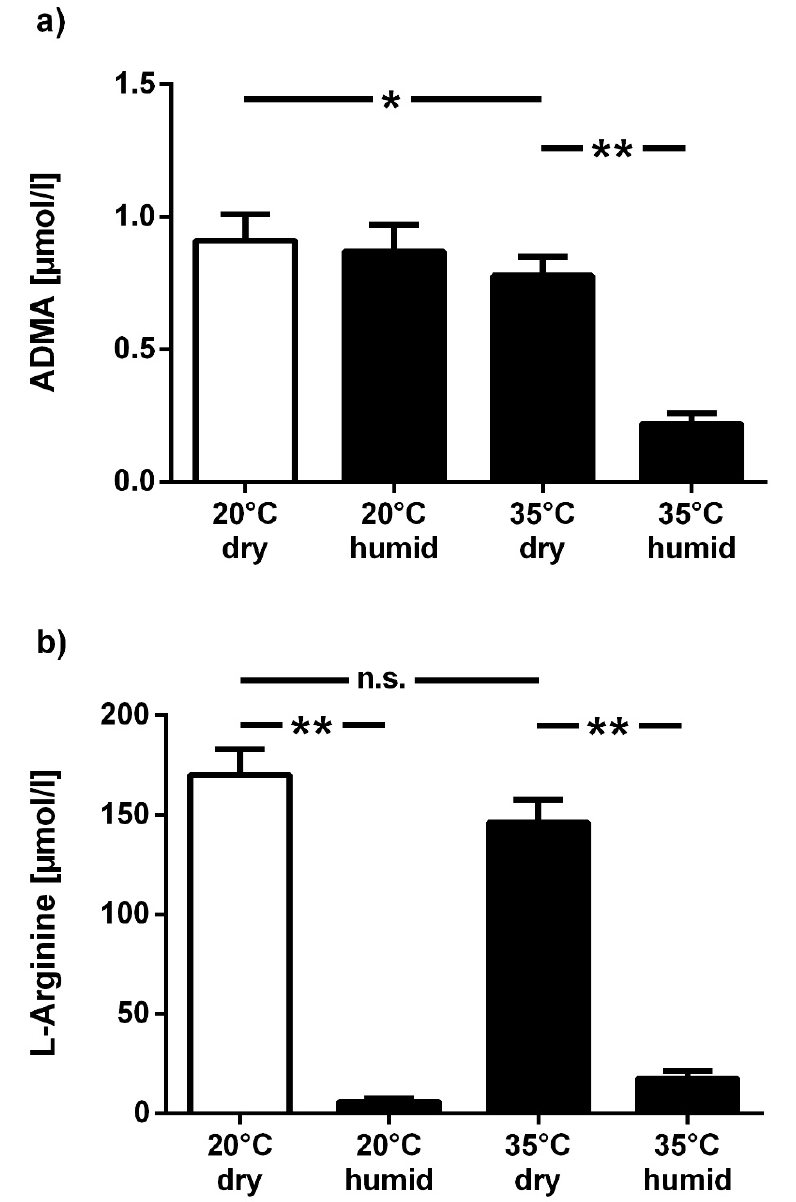
Figure 2. Combined effect of temperature and humidity on dried blood spot assay results. Filter cards were exposed to 20 °C or 35 °C, either at low (40–60%) or high air humidity (95%) for one month, and ADMA ( a ) and L-arginine ( b ) were measured from the dried blood spots. Data are presented as mean ± SD; * p < 0.05, ** p < 0.01 between groups; n.s.: not significant. Comparison of filter cards filled with 50 µL or 100 µL of whole blood revealed no significant difference in ADMA and L-arginine concentration, provided that the filter paper was completely soaked by the blood (ADMA, 0.86 ± 0.01 and 0.93 ± 0.01 µmol/L; L-arginine, 82.2 ± 5.5 and 74.0 ± 11.8 µmol/L, respectively; both p = n.s.).